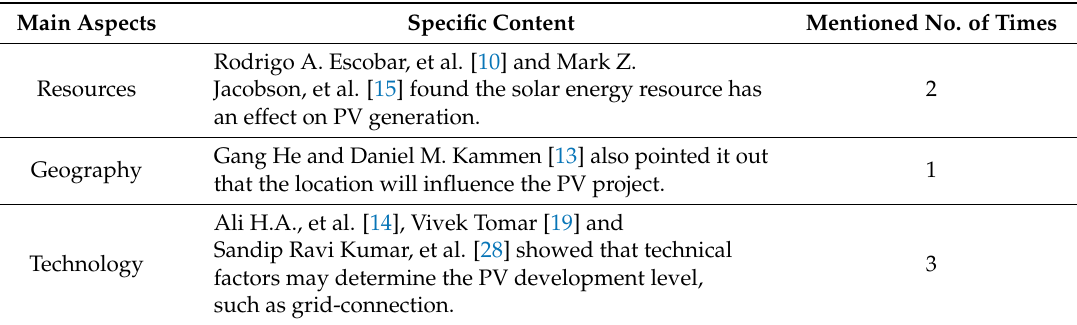
Table 1. Research summary for PV project